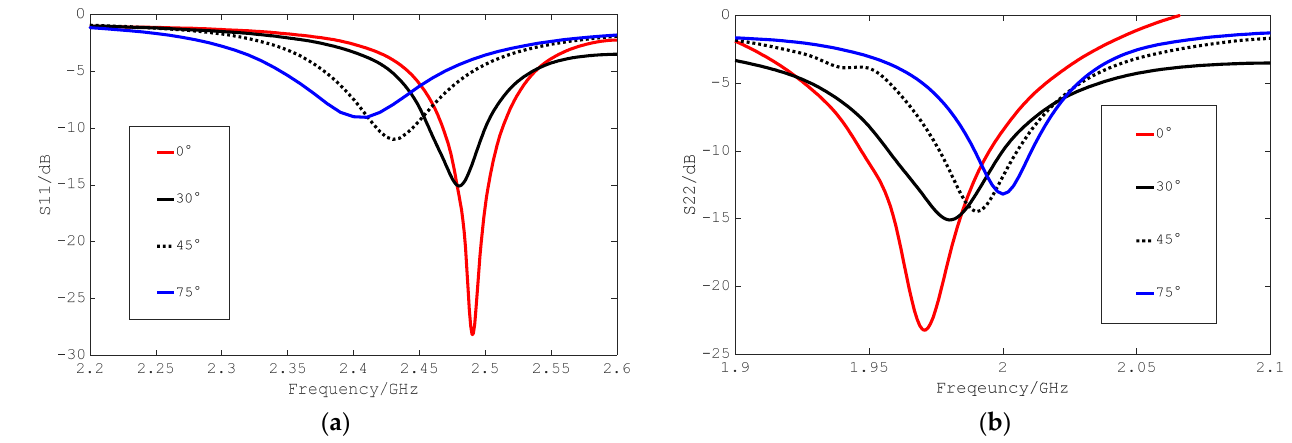
Figure 16. Measured reflection coefficient results of fabricated sensor for crack with different depths. ( a ) Port 1 to horizontal cracks. ( b ) Port 2 to vertical cracks.